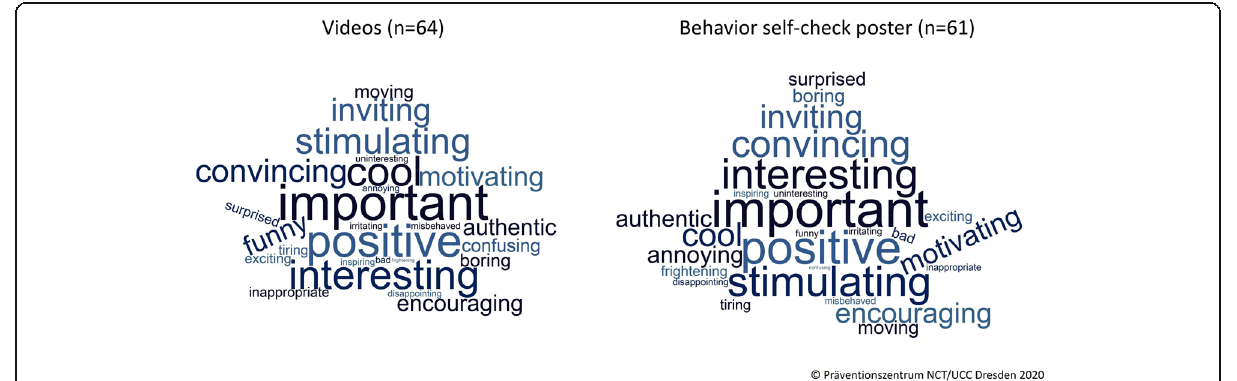
Fig. 4 Acceptance of materials indicated by selected adjectives from students ( n =